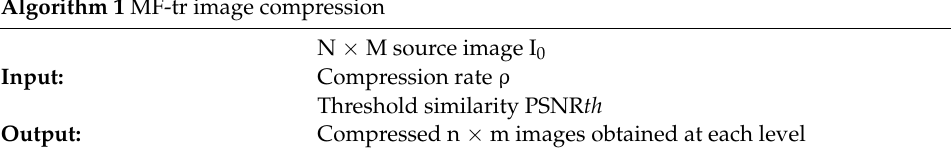
Algorithm 1 MF-tr image